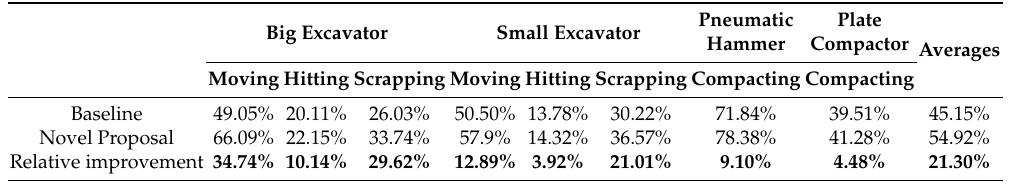
Table 6. Example of table including classification results for two systems (baseline and a novel proposal), and their comparison in terms of relative improvement, calculated as 100 · (reproduced with permission from